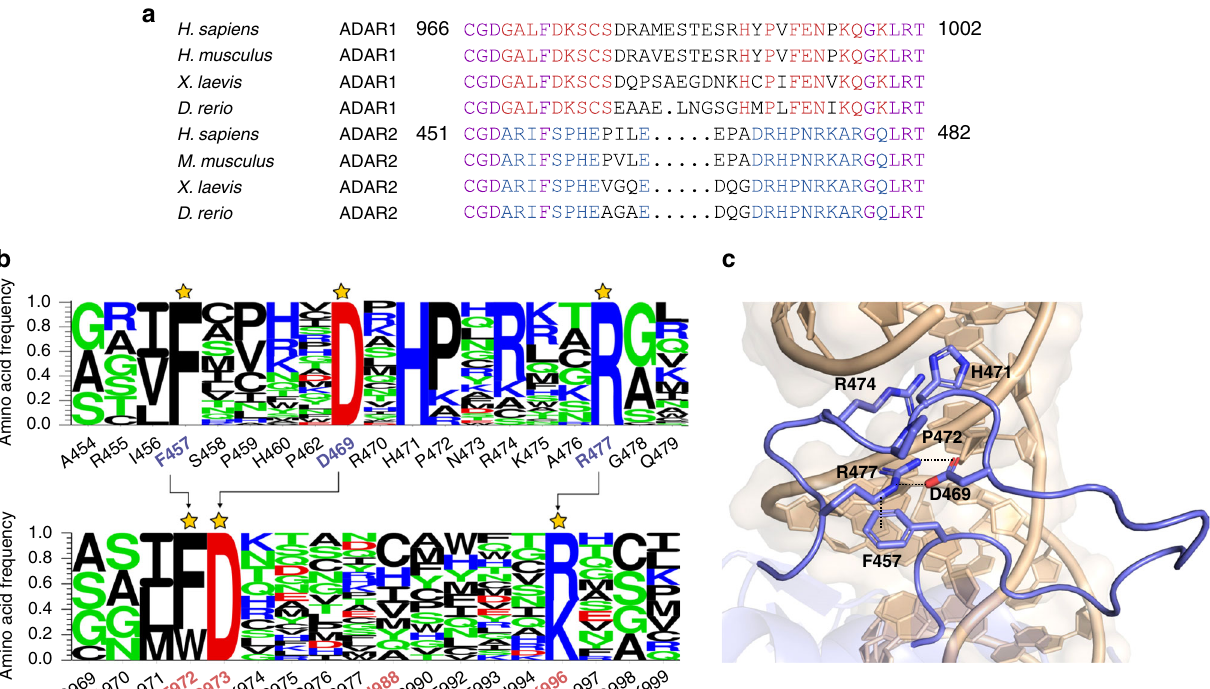
Fig. 7 Comparison of the 5 ′ binding loops of hADAR1 and hADAR2. a Sequence alignment of the 5 ′ binding loop of ADAR1 and ADAR2 from different organisms. Purple: conserved in both ADAR1 and ADAR2, Red: conserved in ADAR1, Blue: conserved in ADAR2, Black: not conserved. b Comparison of Sat- FACS-Seq results for the 5 ′ binding loops of hADAR1 26 and hADAR2 27 . Arrows indicate functionally similar residues in the different loops. c Close-up view of interactions within the 5 ′ binding loop observed in the crystal structure of hADAR2d with dsRNA 21